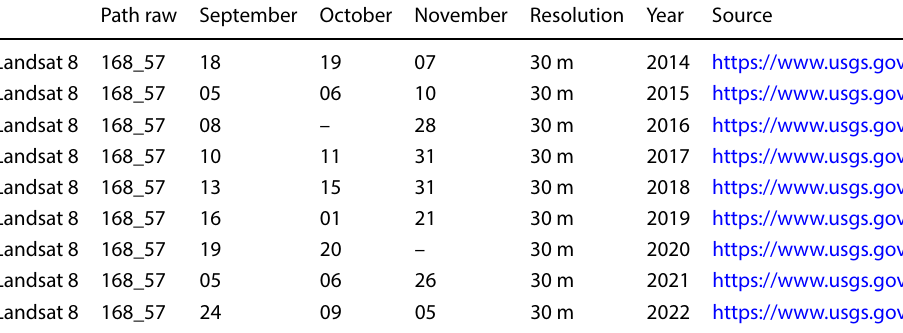
Table 1 Specifications of Landsat data used in the